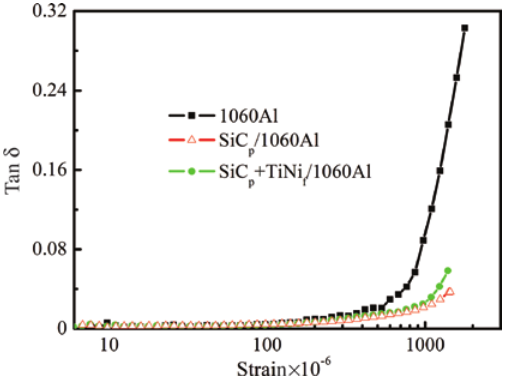
/ Figure 8 Damping capacity vs. temperature curves of the Al matrix, p SiC /Al, and SiC +TiNi /Al p p f